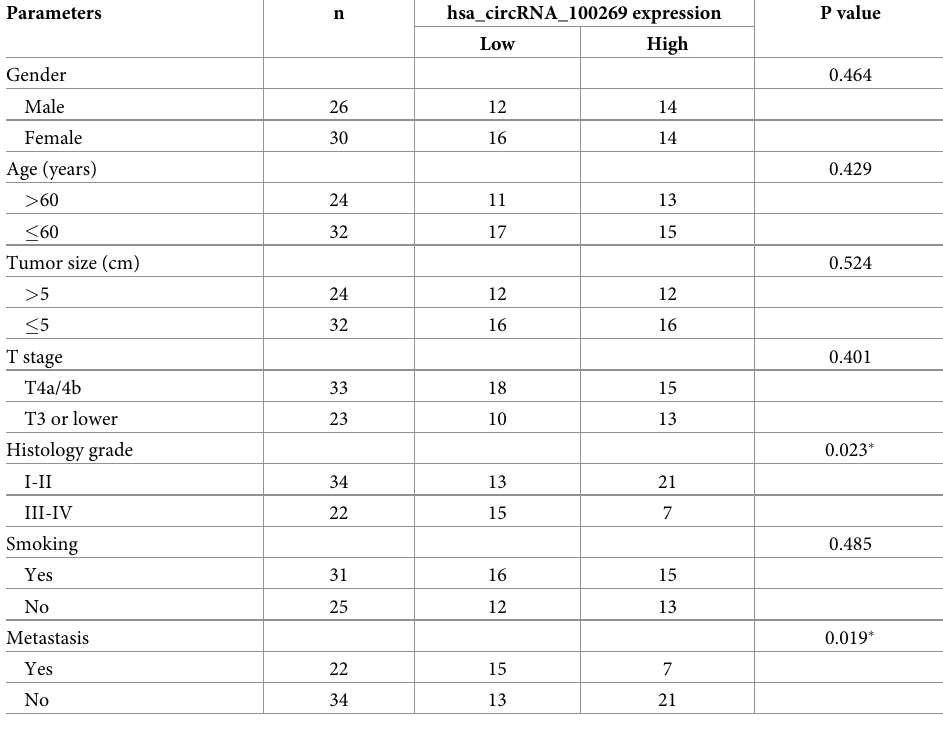
Differences among variable were analyzed using the χ 2 test � indicates that the values have statistically significant